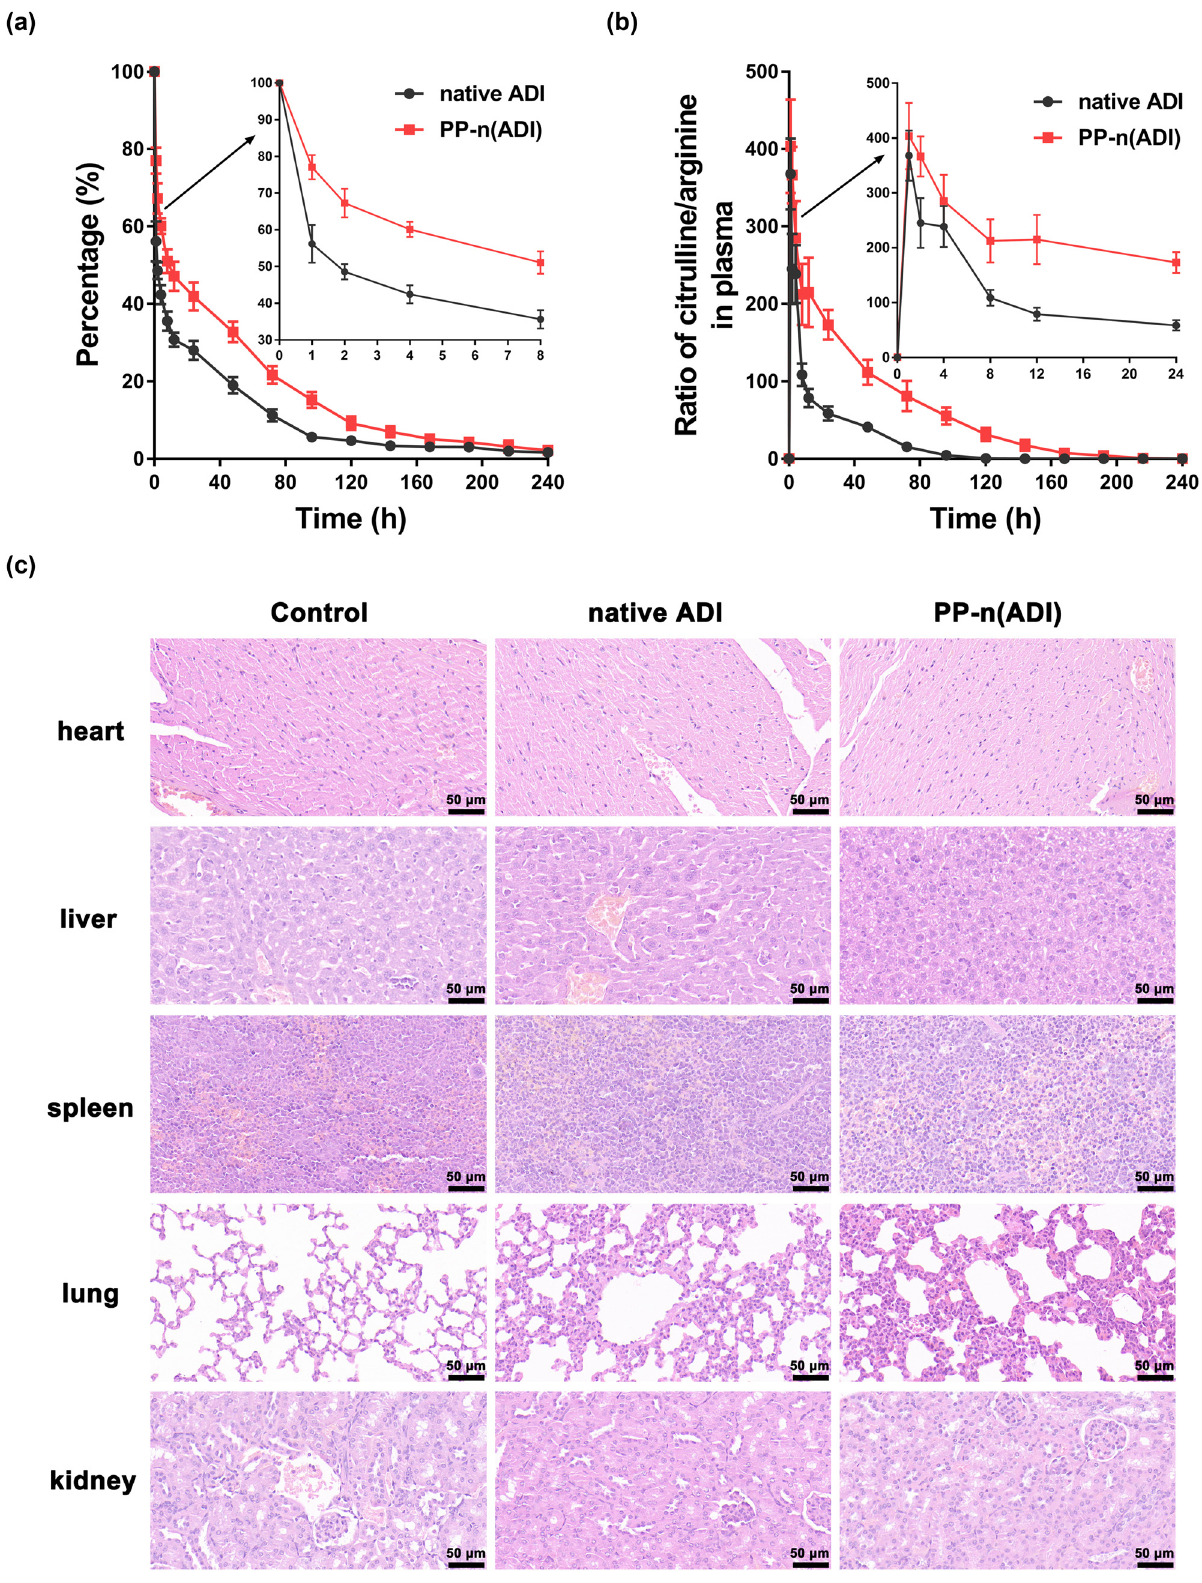
Figure 8: ( a ) The blood circulation time of samples. FITC was used to label ADI. ( b ) Samples ( ∼ 1 mg ) were intravenously injected into the mice once, and the ratio of Cit to Arg in corresponding mice plasma was measured. ( c ) Images of H&E staining of histological sections of